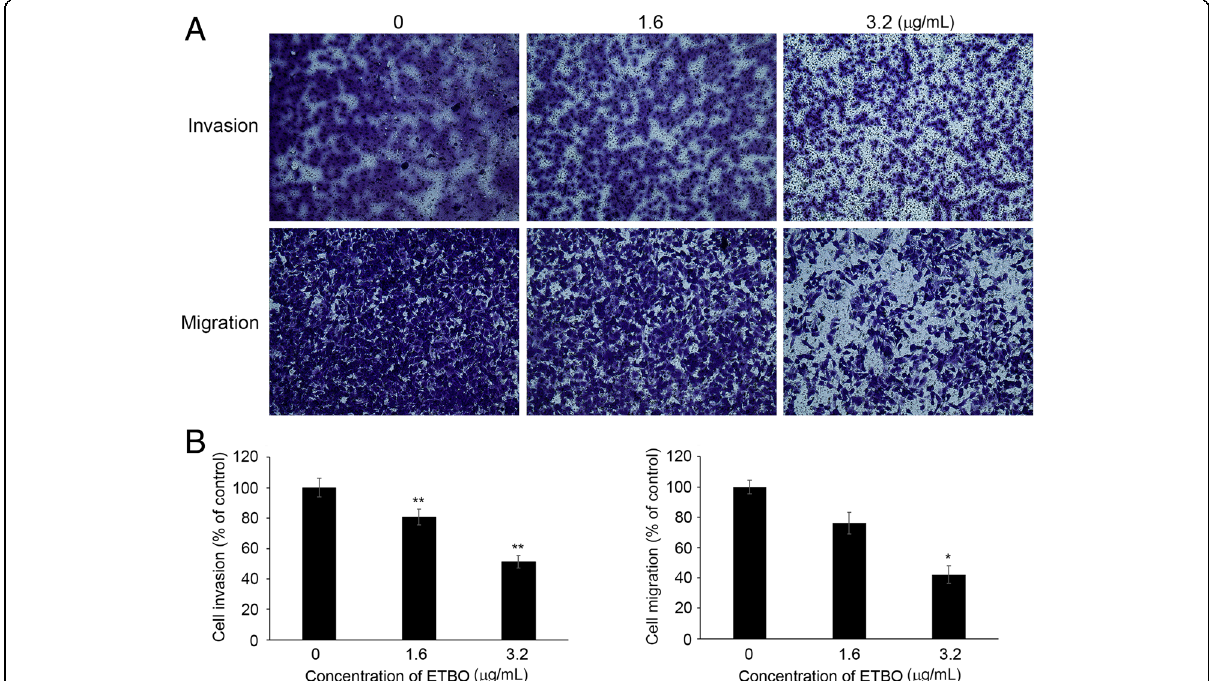
Fig. 6 Effect of ETBO on cellular invasion and migration. Cells (HeLa) were treated with or without different concentrations (1.6 and 3.2 μ g/mL) of ETBO for 24 h ( a ). The quantitation of the results from three independent experiments (n = 3) is shown as the mean ± SD with statistical significance as * p < 0.05 and ** p < 0.01 between the control and ETBO-treated group ( b ). ETBO, Ethanol extract of Botryidiopsidaceae